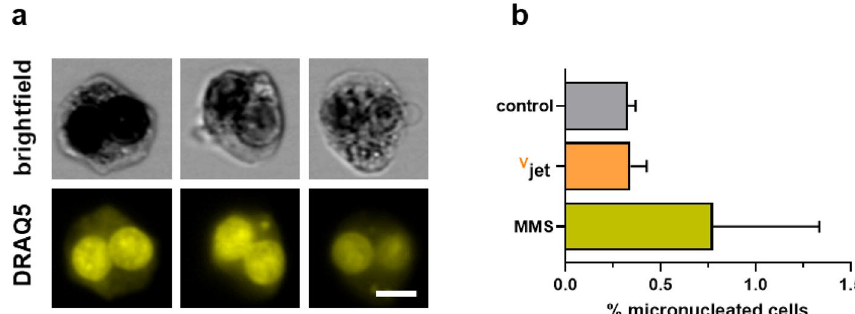
Figure 7. Assessment of genotoxic safety using an image flow cytometry-based micronucleus assay. ( a ) representative brightfield (BF) and DRAQ5 fluorescence images of binucleated cells having none (left), one (middle), and two (right) micronuclei in their cytosol, and ( b ) quantification of single micronucleated among all binucleated cells in the different conditions. Data are of three independent